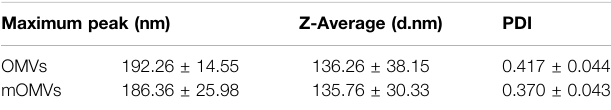
TABLE 1 | Size distribution parameters of OMVs and modi fi ed OMVs (mOMVs) determined by DLS a . Maximum peak (nm)